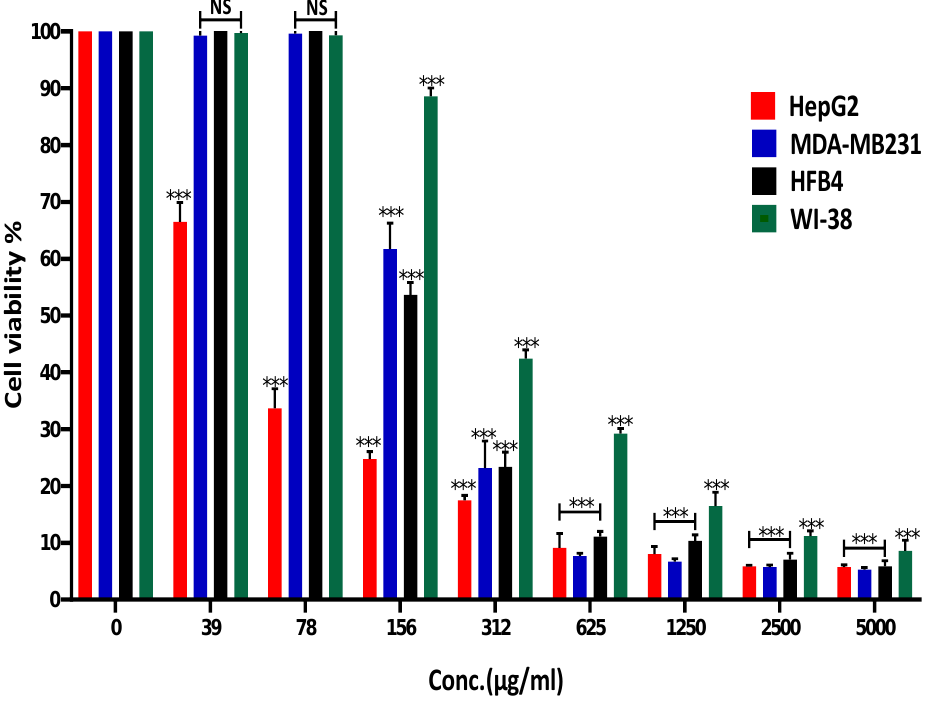
Figure 2. Effects of R. nomadica venom on cell proliferation of HepG2, MDA-MB231, HFB4, and WI-38 cell lines at different concentrations. The percentage of cell viability was measured using MTT assay after 48 h treatment. Non-treated cells were used as a control. Data are analyzed with one-way ANOVA followed by Tukey’s test. All values are represented as mean ± SEM. *** denotes significance difference ( p < 0.001) vs. control, otherwise noted NS: non-significant ( p > 0.05).